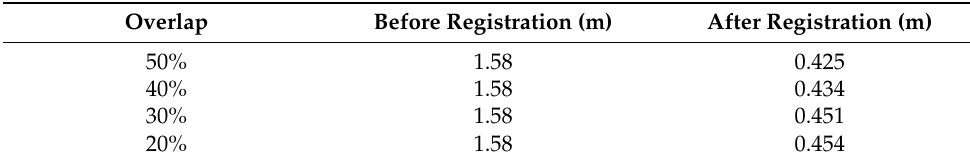
Table 3. RMSE calculation results before and after registration.